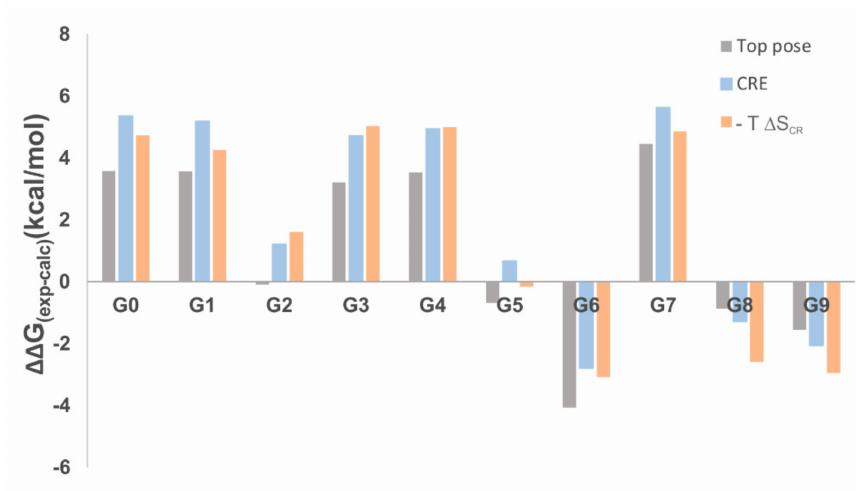
Figure 8. Deviations of GFN2-xTB CREST results from experiment in kcal/mol for ligands G0 to G9 binding to CB[8]. Grey: Gibbs free energy of binding for top pose only; blue: For all members of the CRE; orange: Taking into account changes in conformational and rotational entropy of the ensemble ( − T ∆ S CR ).